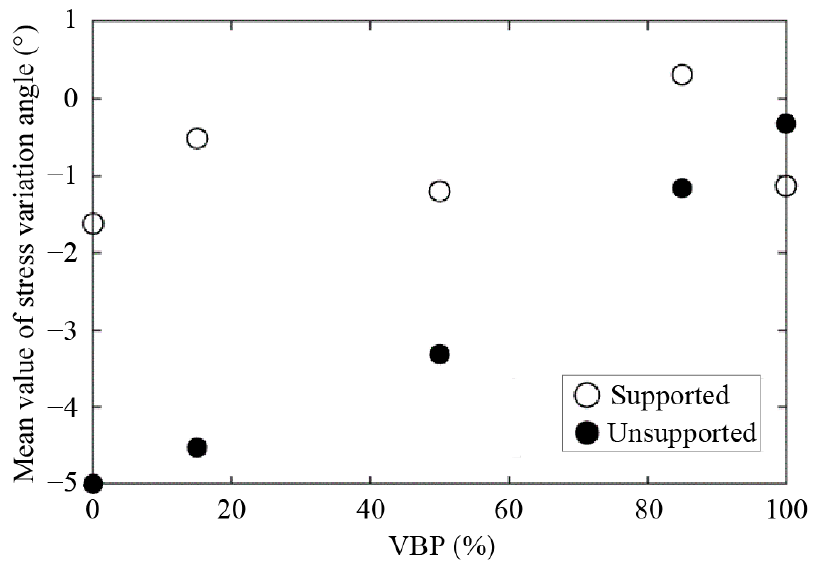
Figure 16. The mean value of stress variation angle distributed in the talus-like rock mass as a function of VBP.